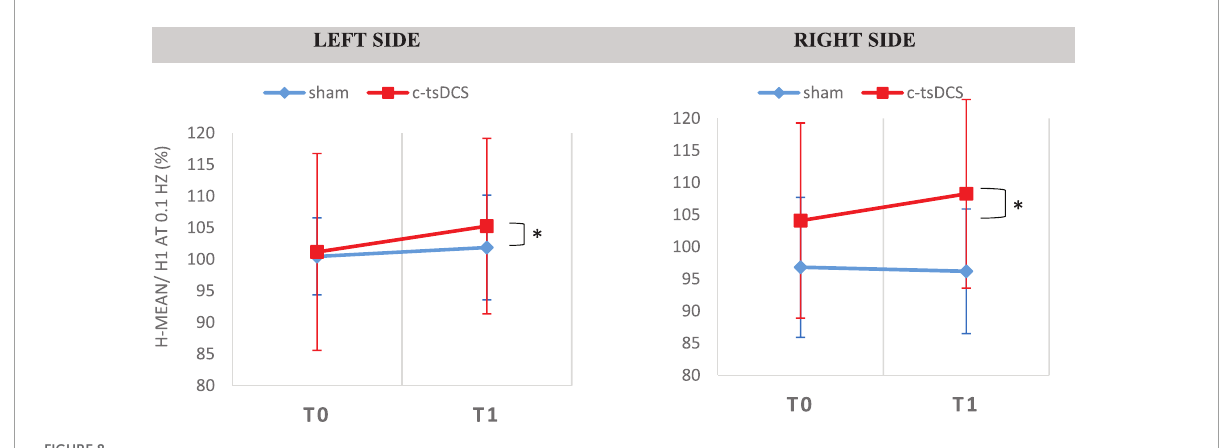
FIGURE8 Soleus H-Reflex elicited at 0.1 Hz in the two conditions [Sham and c-tsDCS for the two types of intervention (sham–blue trace and cathodal—red trace)]. H-reflex was obtained in the soleus muscle, for the both sides. [H-mean/H1 at 0.1 Hz (%)—size of mean reflex evoked (%) of mean reflex evoked at 0.1 HZ]. ∗ A statistically significant difference ( p < 0.05).